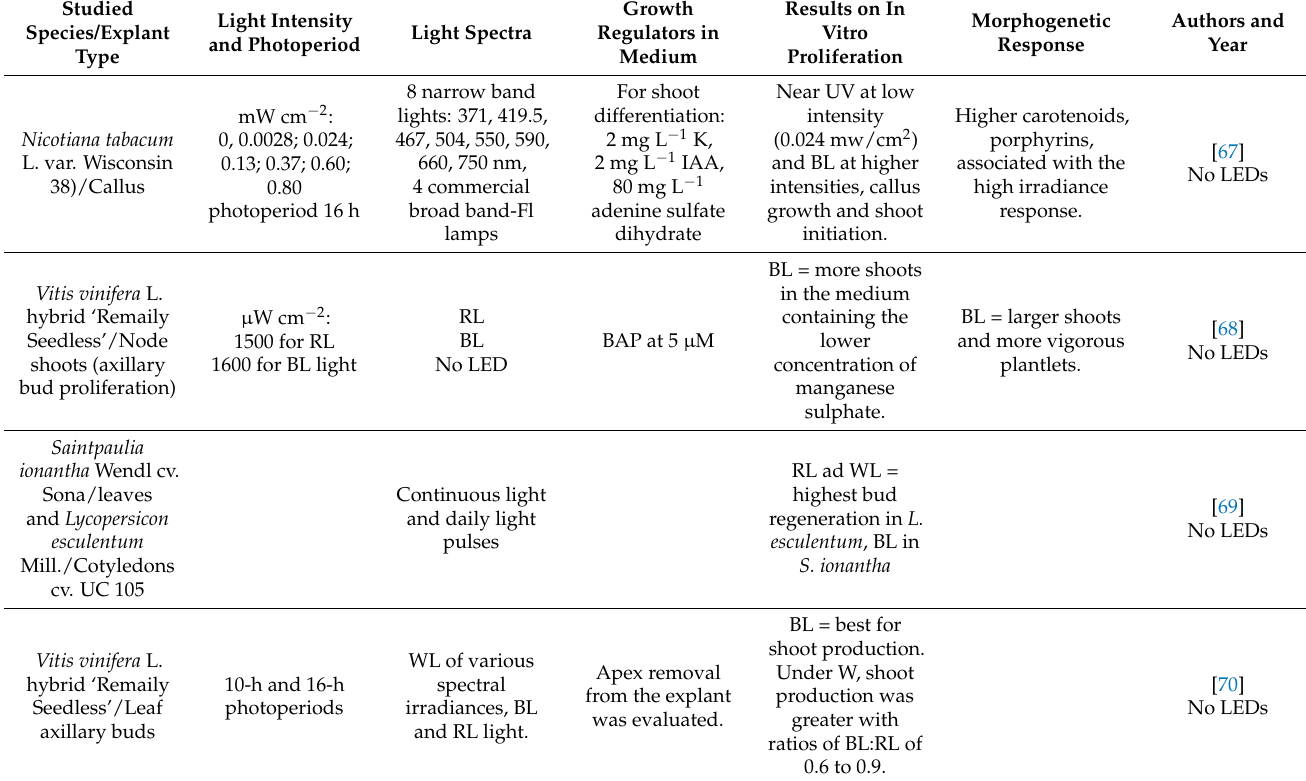
Table 1. Summary of the use of LED lighting on in vitro propagation of herbaceous and shrub